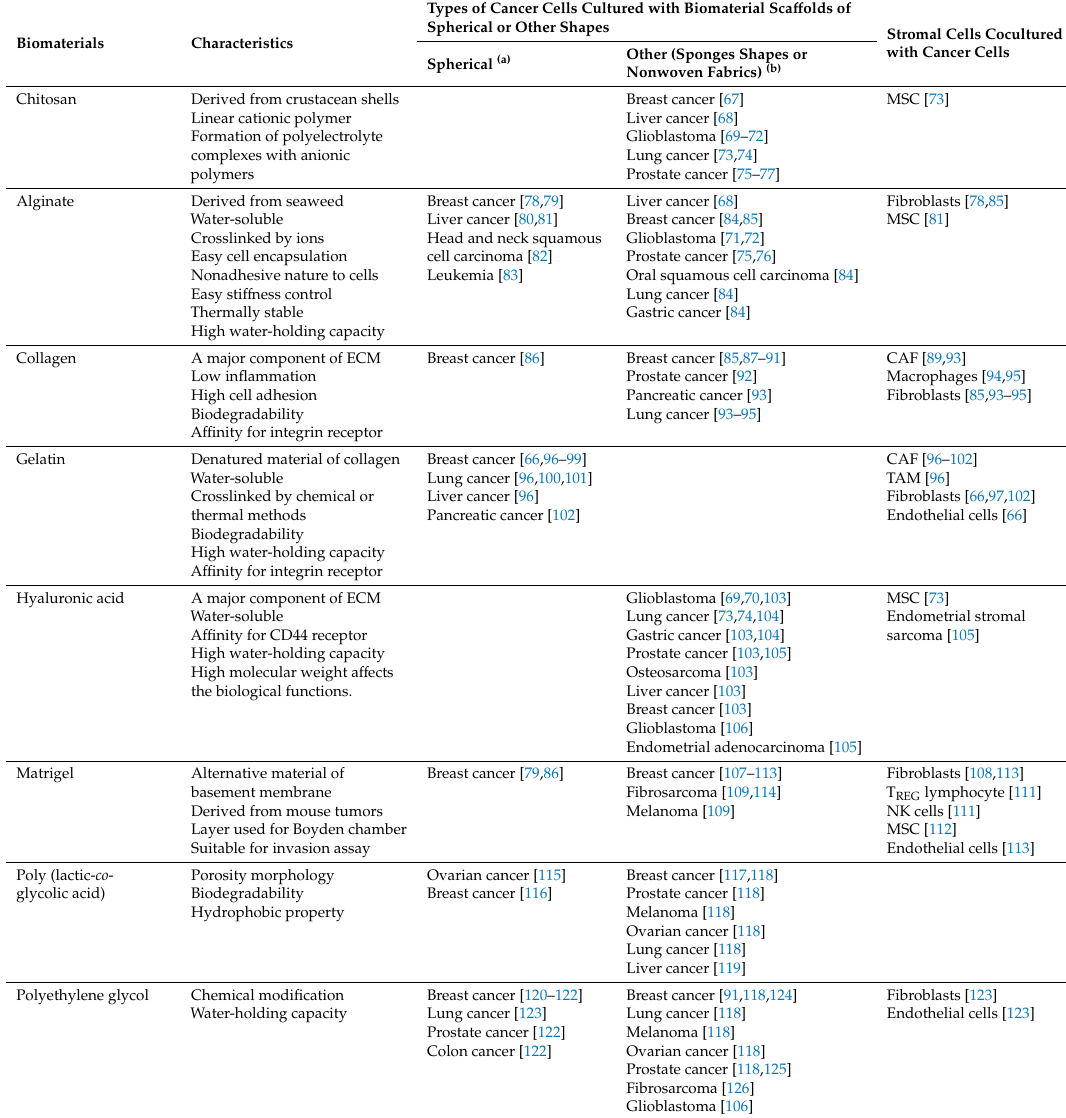
Table 3. 3D culture system of cancer cells combined with